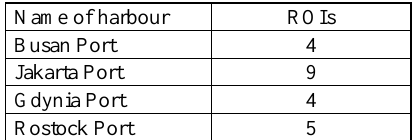
Table 1. Number of ROIs extracted on each image